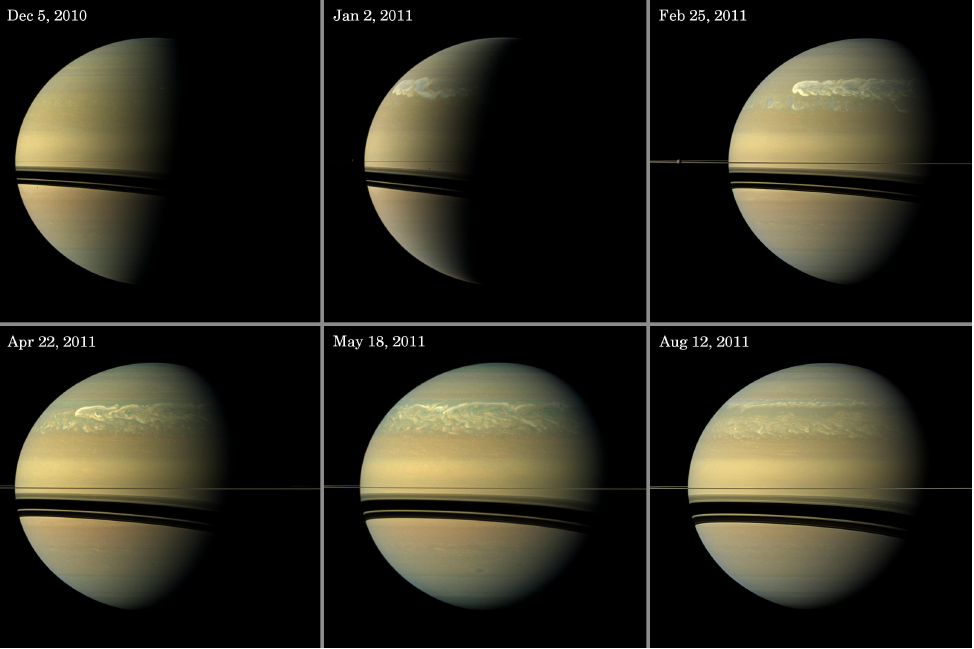
Figure 5. Evolution of the GWS on Saturn from Cassini observations. The storm started in the northern mid-latitudes and within a few months encompassed the entire latitudinal band producing vortical wakes. Image credits: NASA/JPL-Caltech/Space Science